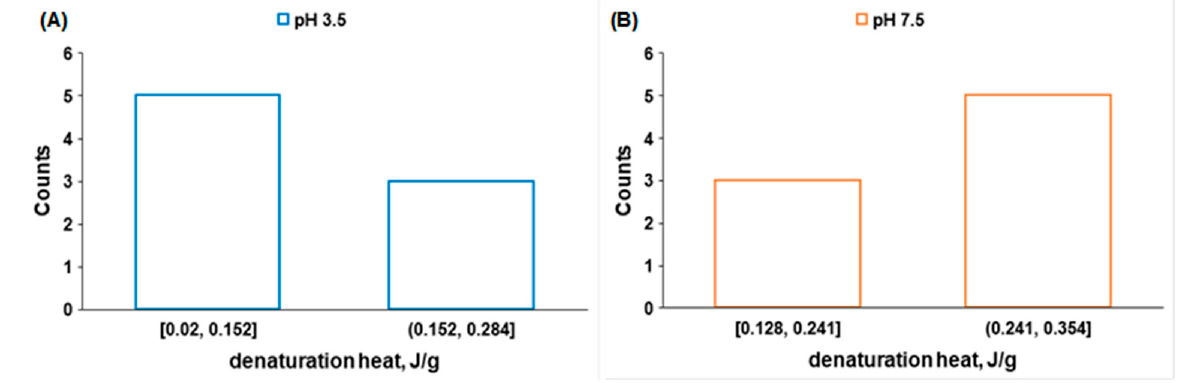
Figure 8. Denaturation heat histograms of collagen systems at pH 3.5 ( A ) and 7.5 ( B ).